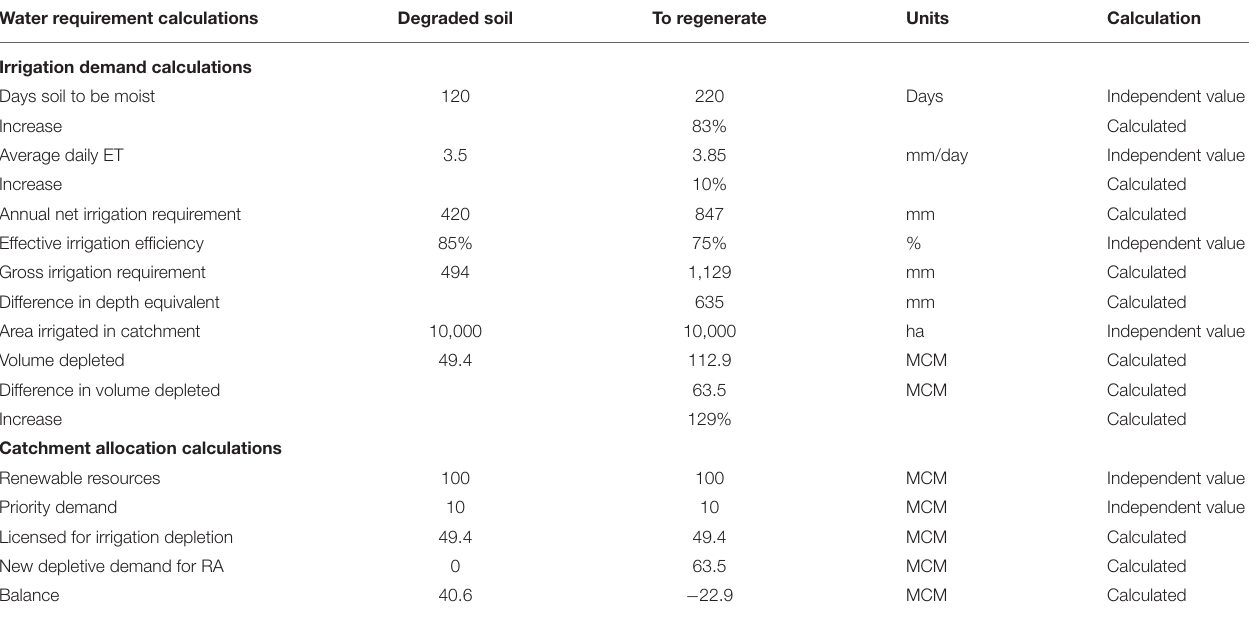
TABLE 3 | Extra water is consumed in irrigation to regenerate